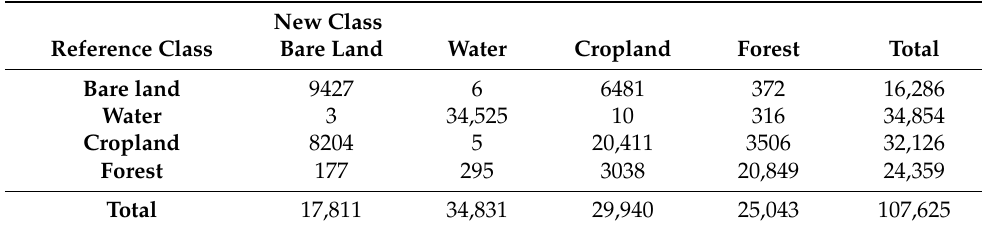
Figure 16. Map of changes in LULC from 2010 to 2021. Table 3. The transition between LULC classes in the study area from 2010 to 2021. Reference classes referred to LULC in 2010, and new classes were current LULC in 2021. Measurements are presented in